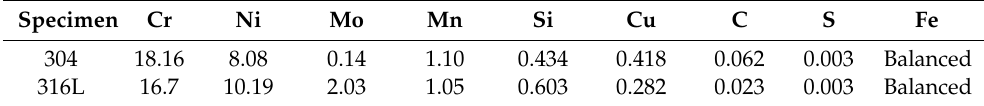
Table 1. Chemical composition of 304 and 316L stainless steels.